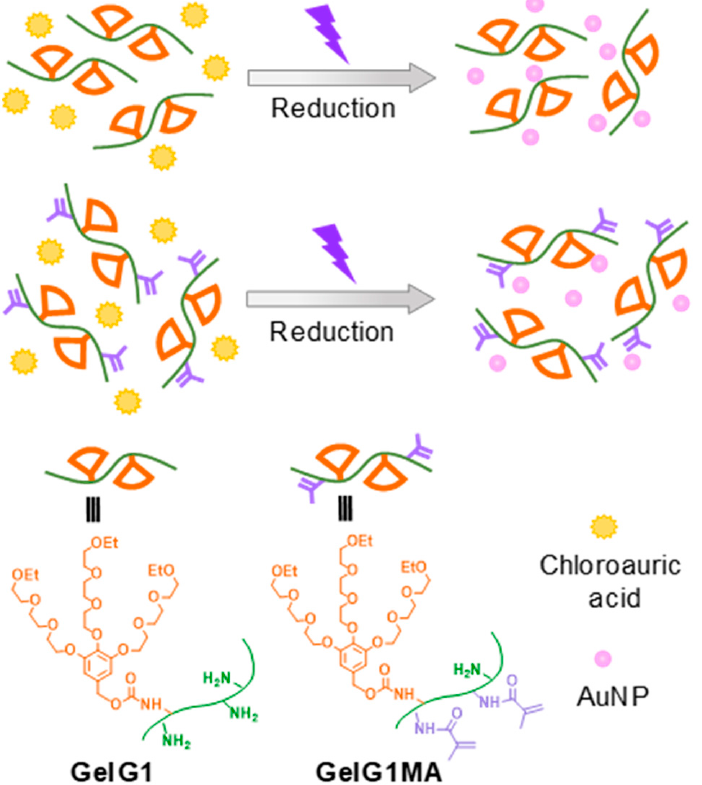
Figure 1. Illustration of synthesis of AuNPs in the matrix of dendronized gelatins ( GelG1 s) and dendronized gelatin methacrylates ( GelG1MA s) triggered by UV irradiation.